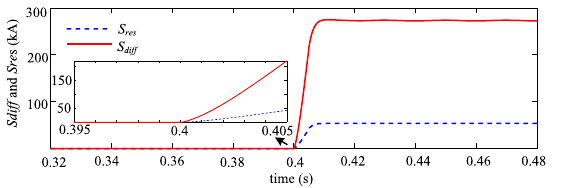
Fig. 10 Protection performance for fault occurring at f 3